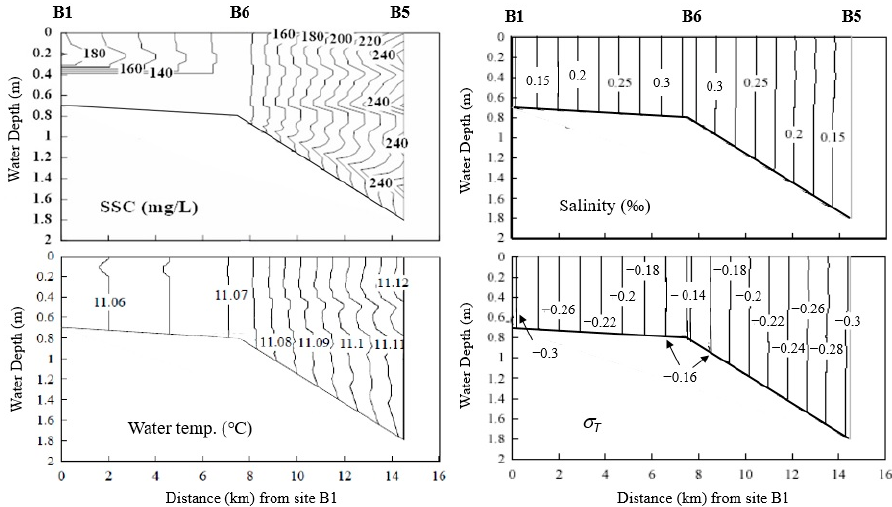
Figure 6. Traverse cross-sections of SSC, water temperature, salinity, and marine water density σ T by the coastal observation on the B1–B5 line on 6 September 2009 (Figure